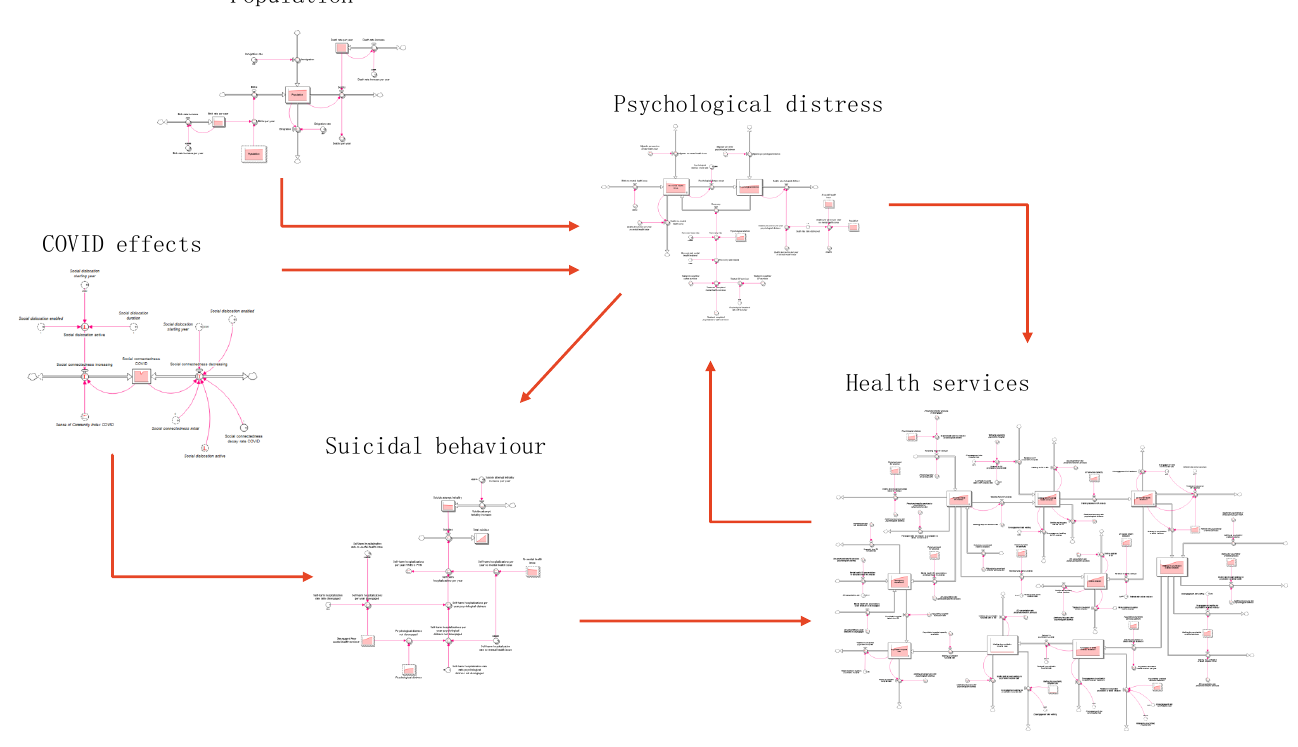
Figure 1. High-level map of the core system dynamics model showing the causal connections among model sectors. Single-headed arrows indicate unidirectional causal connections; bidirectional causal connections are shown as double-headed